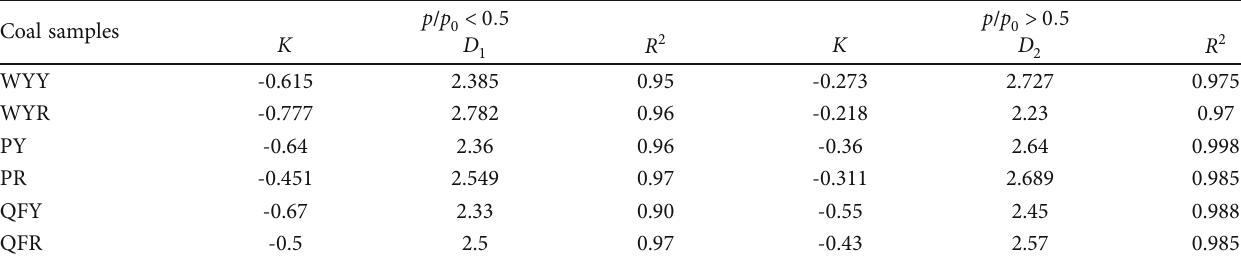
Table 2: Fractal dimension result of coal